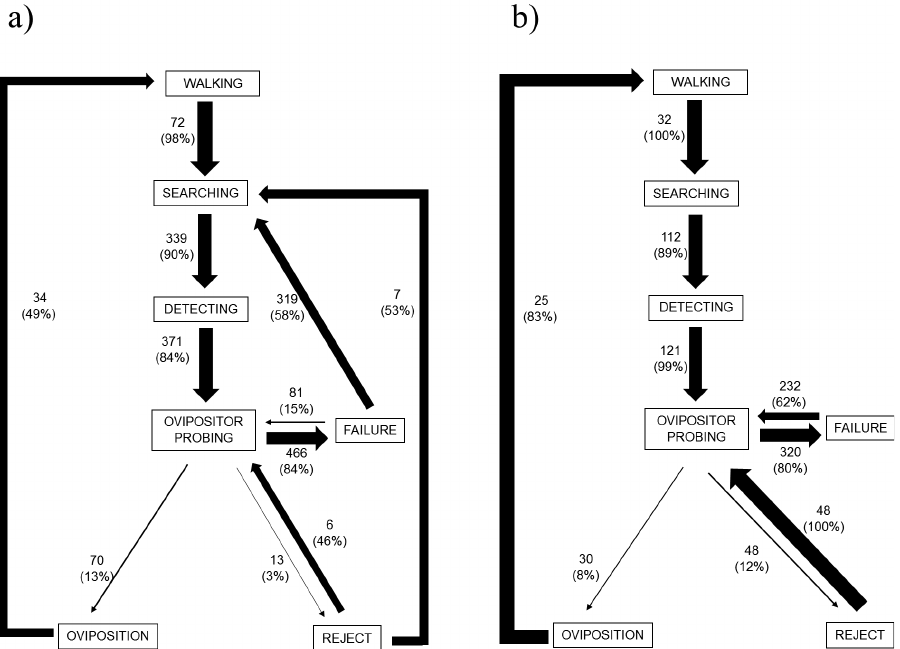
Figure 3. Ethogram of oviposition of females of Opius hirtus on non-parasitized larvae ( a ) and larvae previ- ously parasitized by conspecifics ( b ) under laboratory conditions. The width of the arrow is proportional to the relative frequency of transition. The numbers associated with the arrows represent the observed frequen- cies of the successive behaviors of a complex sequence of behavior (proportions are indicated in